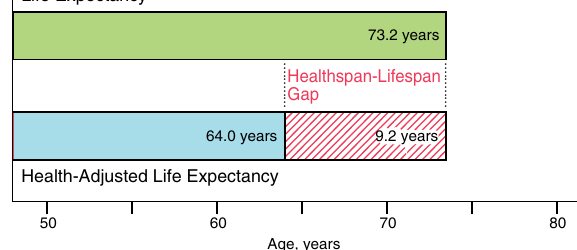
Fig. 2 Healthspan-lifespan gap. Lifespan is the total number of years lived by an individual. Healthspan is the number of disease- free years lived. Life expectancy and health-adjusted life expectancy are population-level measures of lifespan and healthspan, respec- tively. A gap of 9-year is deduced from comparing 2020 data for median probabilistic projection of life expectancy and health- adjusted life expectancy.